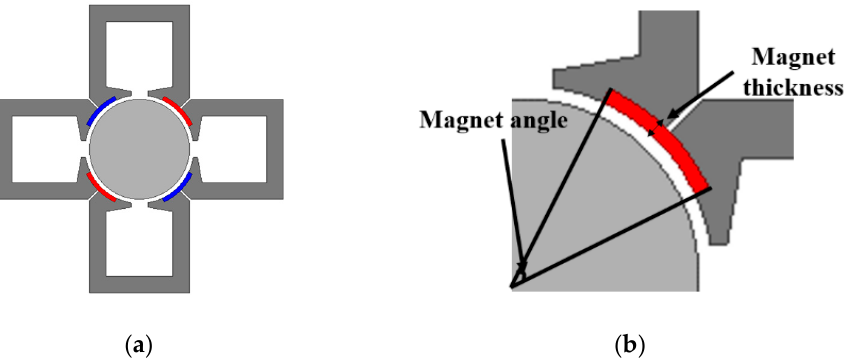
Figure 10. HSTMB full model and variables of the magnet: ( a ) HSTMB full model and ( b ) variables of the magnet.